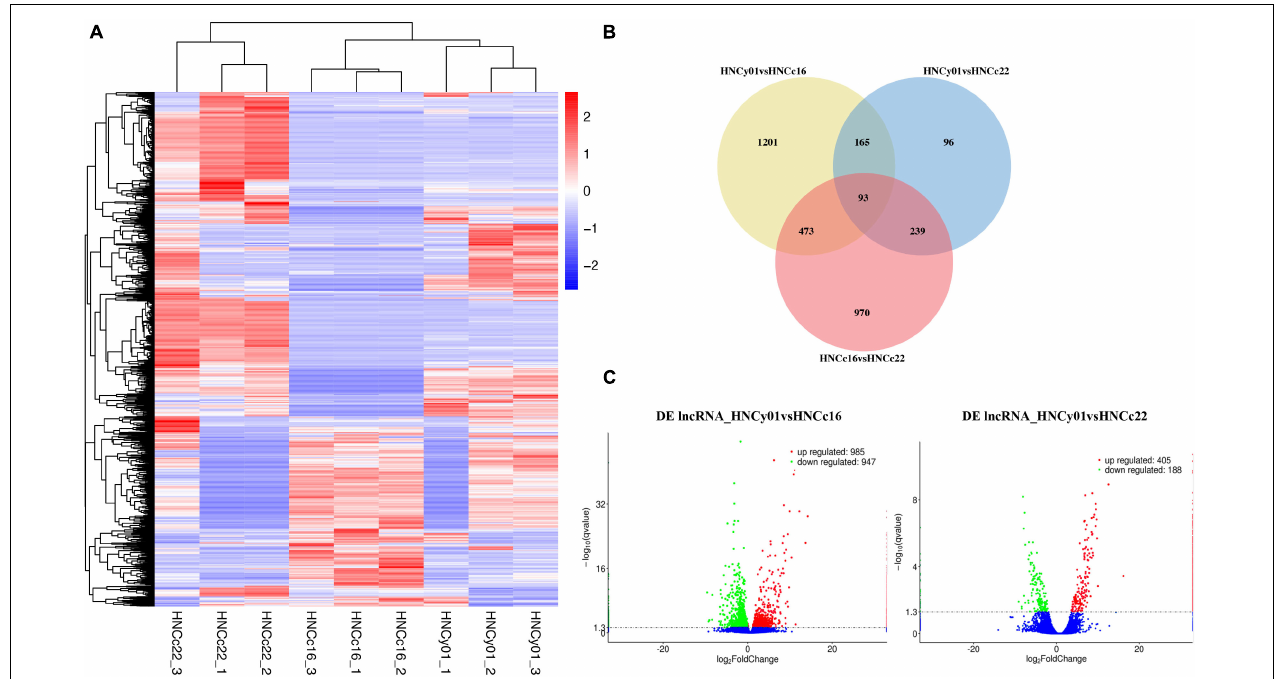
FIGURE 7 | Significantly differentially expressed lncRNAs between the hybrid and its parents at the seedling stage. (A) Hierarchical cluster analysis of DE lncRNAs. (B) Venn diagram of DE lncRNAs in HNCy01vsHNCc16, HNCy01vs HNCc22, and HNCc16vs HNCc22. (C) Volcano plot of DE lncRNAs in HNCy01vsHNCc16 and HNCy0vsHNCc22. Upregulated, downregulated, and non-differentially expressed genes are represented by red, green, and blue dots, respectively.